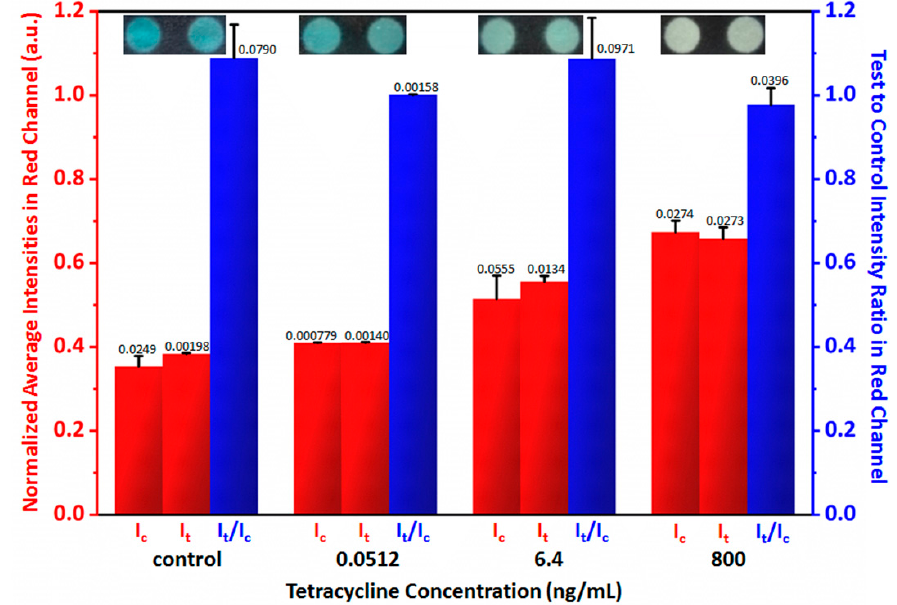
Figure 4. Certification of the handheld inkjet printing paper chip based smart tetracycline detector. The numbers on the columns represent standard deviations computed from 5 measurements.